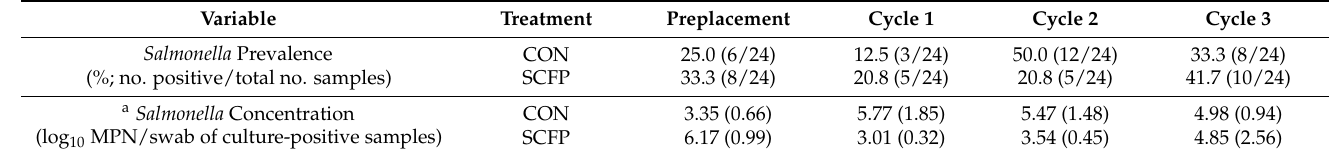
Figure 1. Treatment level Salmonella enterica litter prevalence ( A ) and load ( B ) LS means estimates with and without adjustment for covariates. Error bars reflect 95% confidence intervals with significant differences within estimate types denoted by superscripts a,b at p < 0.05. Dots represent individual observed values. Table 1. Observed prevalence and load of Salmonella enterica in the litter of broiler houses freshly sourced and after each of three consecutive rearing cycles of birds fed either CON or SCFP diets.